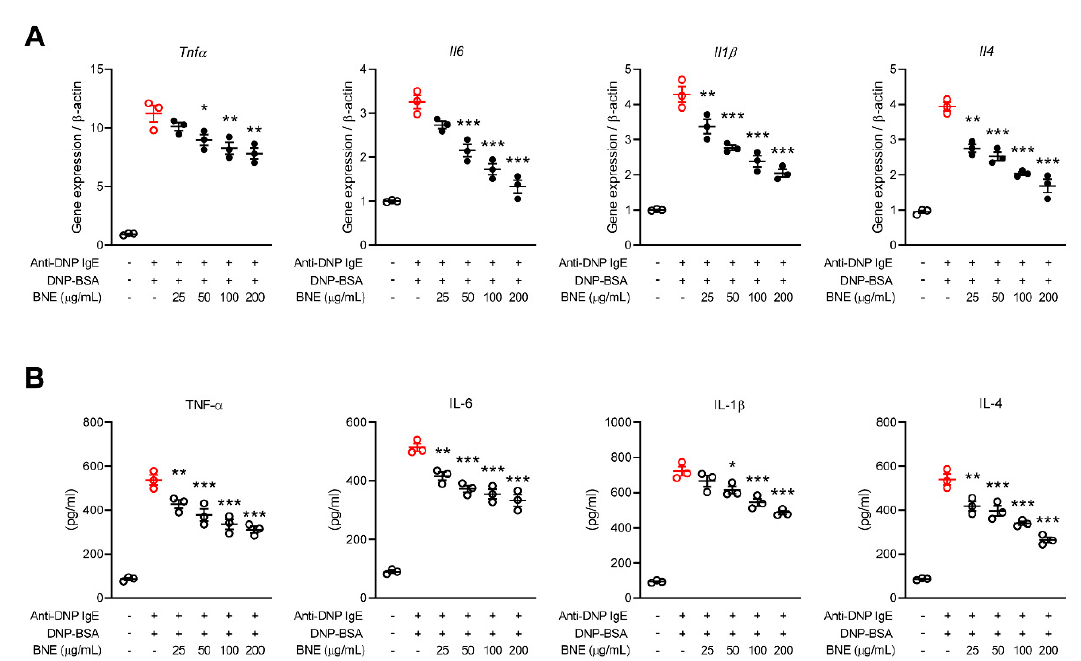
Figure 2. E ff ects of BNE on the expression and / or secretion of inflammatory cytokines. ( A , B ) RBL-2H3 cells were pre-sensitized with anti-DNP IgE (5 × 10 5 cells / well). The cells were activated with anti-DNP-BSA by pretreating with or without DNE, and qPCR was used to quantify the expression of inflammatory cytokine (TNF- α , IL-1 β , IL-6, and IL-4) genes ( A ). ( B ) Analysis of cytokines in the cultured supernatant for 6 h by ELISA. Data represent the mean ± SEM from three independent experiments. * p < 0.05; ** p < 0.01; *** p < 0.001, Tukey’s test, significantly di ff erent from Anti-DNP IgE plus DNP-BSA-treated group. Anti-DNP IgE, anti-dinitrophenyl immunoglobulin E; DNP-BSA, dinitrophenyl-Bovine serum albumin; BNE, Boehmeria nivea extract; TNF- α , tumor necrosis factor- alpha; IL, interleukin.